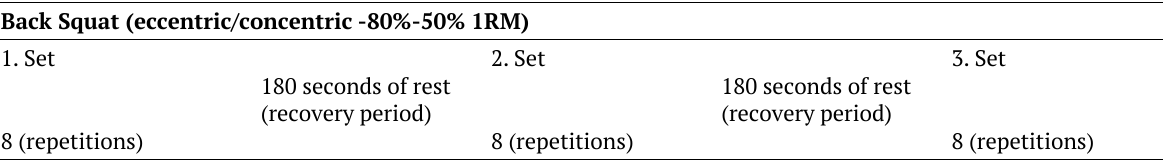
Table 2. Accentuated eccentric load traditional set training protocol Back Squat (eccentric/concentric -80%-50%